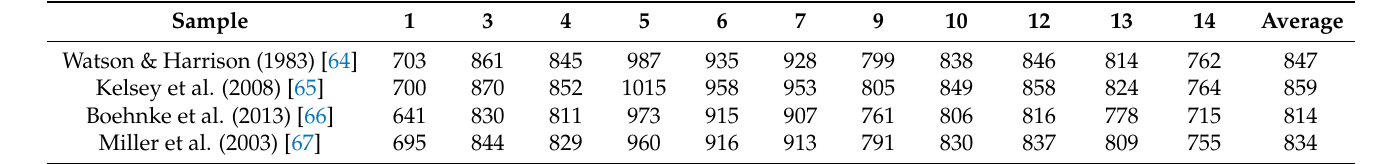
Figure 11. Plots of Wadhrai analyses for estimation of pressure and temperature conditions for the Wadhrai granitic rocks. ( A ) Normative Quartz–Albite–Orthoclase diagram showing experimentally calibrated isobars after [59,63]. ( B ) Rb against Sr plots and pressure relations after [61]. ( C ) Zircon saturation temperature estimates, calculated after the procedures reported in [62–65]. Zircon saturation temperatures (Table 3, Figure 11C), varying between 770 and 870 ◦ C, were obtained from the Wadharai granites using the procedures of [64–67]. These estimates are similar to those (784 to 918 ◦ C) obtained for Nagar Parkar pink and grey granites [47], and likely represent operating temperatures during magma generation. Table 3. Zircon saturation temperatures from the analyzed samples of Wadhrai granite.